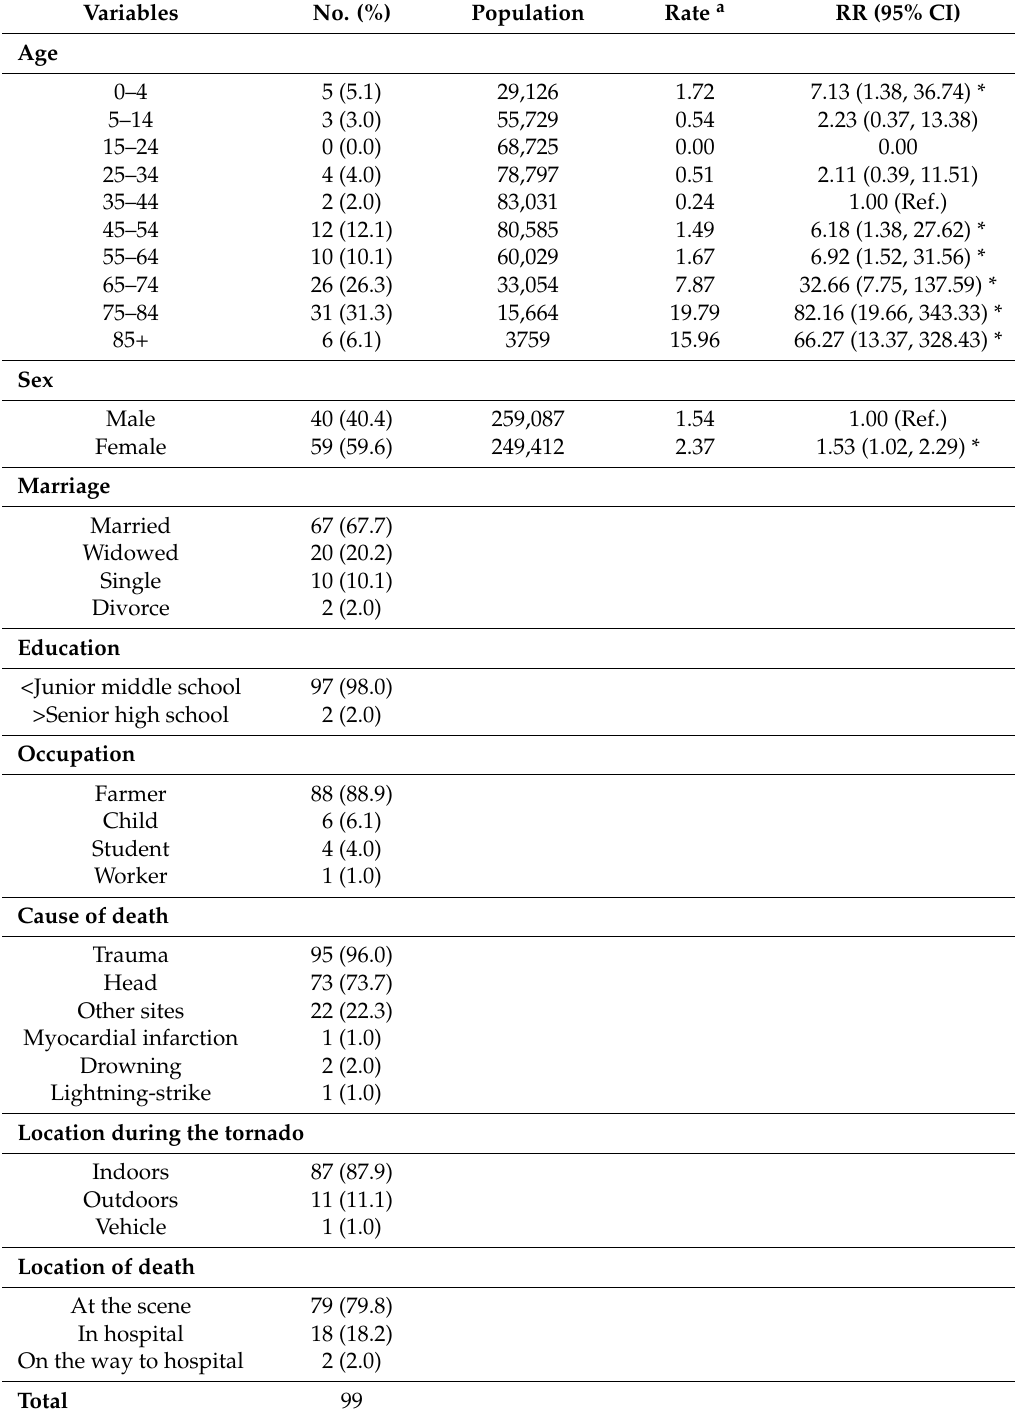
Table 1. Demographics and circumstances of decedents in the Funing tornado, 23 June